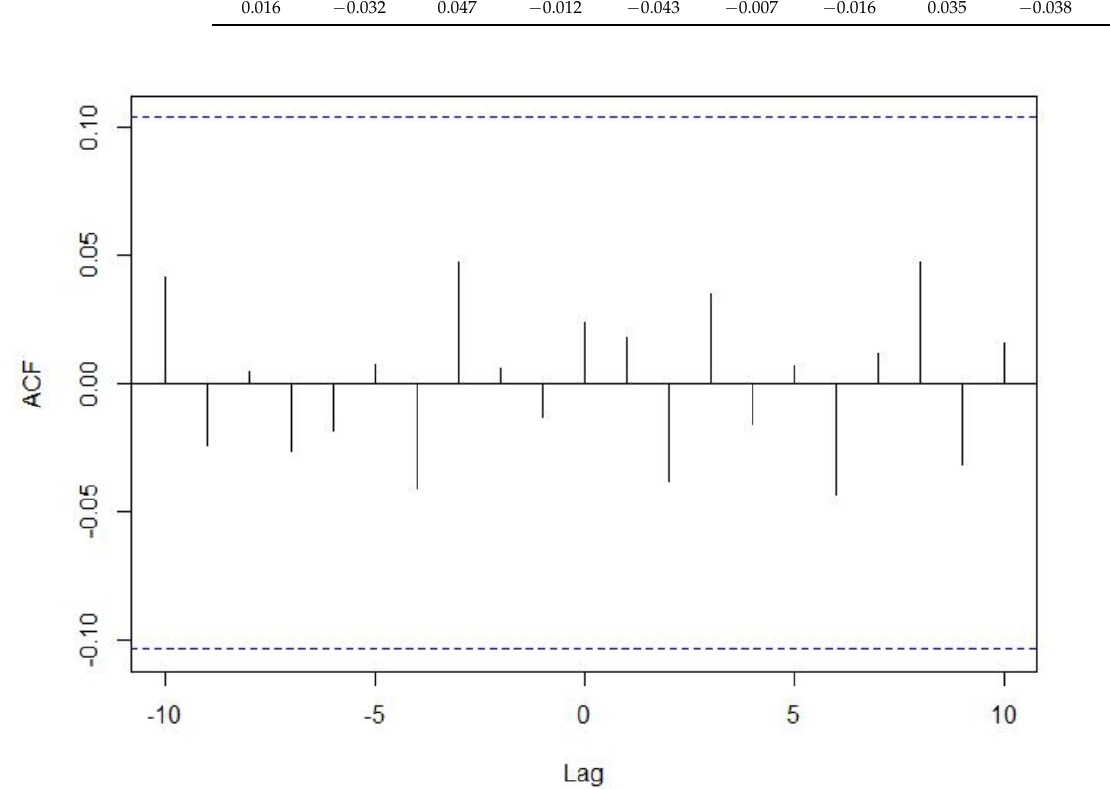
Figure 15. Cross-correlation between variations in daily posts and